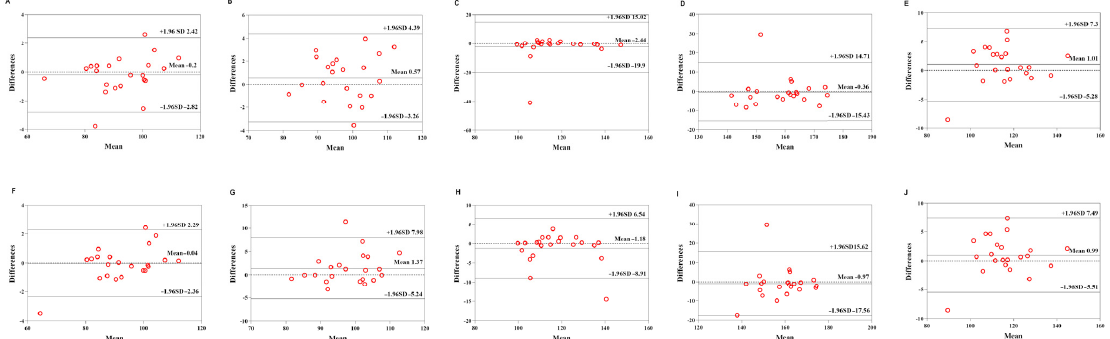
Figure 3. Comparison between the Lexin Mio smart bracelet (Mio) and Polar Heart Rate Monitor (Polar) for heart rate (HR) in the low-physical-activity level (LPAL) group. ( A ) Bland–Altman plots of mean of left Mio and Polar for HR under rest condition. ( B ) Bland–Altman plots of mean of left Mio and Polar for HR under the low-intensity exercise. ( C ) Bland–Altman plots of mean of left Mio and Polar for HR under the middle-intensity exercise. ( D ) Bland–Altman plots of mean of left Mio and Polar for HR under the high-intensity exercise. ( E ) Bland–Altman plots of mean of left Mio and Polar for HR under recovery condition. ( F ) Bland–Altman plots of mean of right Mio and Polar for HR under rest condition. ( G ) Bland–Altman plots of mean of right Mio and Polar for HR under the low-intensity exercise. ( H ) Bland–Altman plots of mean of right Mio and Polar for HR under the middle-intensity exercise. ( I ) Bland–Altman plots of mean of right Mio and Polar for HR under the high-intensity exercise. ( J ) Bland–Altman plots of mean of right Mio and Polar for HR under recovery condition.